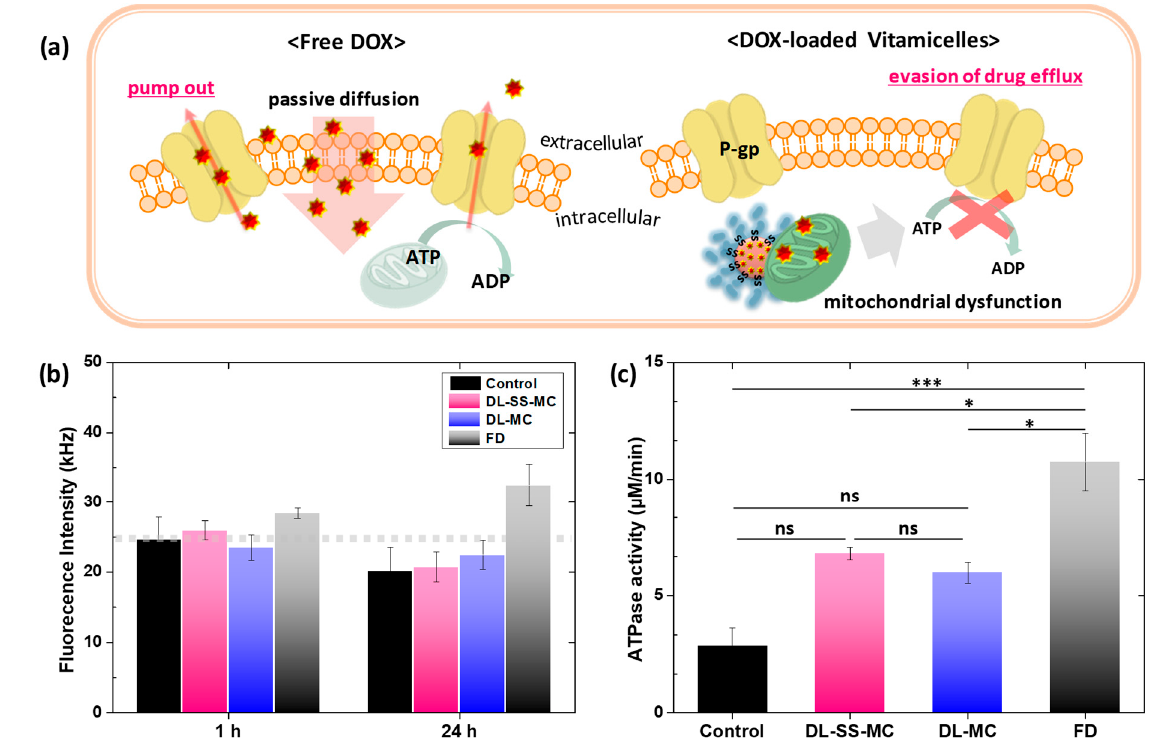
Figure 8. ( a ) Schematic illustration of the drug efflux mechanism that removes free DOX ( a ), and intracellular trafficking of DOX-loaded vitamicelles in cancer cells. ( b ) Fluorescence intensity of DOX in the extracellular fluid around Huh-7 cells after incubation with DL-SS-MC, DL-MC, or FD for 1 or 24 h. ( c ) ATPase assay to test drug efflux from Huh-7 cells incubated with DL-SS-MC, DL-MC, or FD. Data are presented as the mean ± SD of triplicate experiments: ns (not statistically significant, p > 0.05), * p > 0.05, *** p < 0.001.